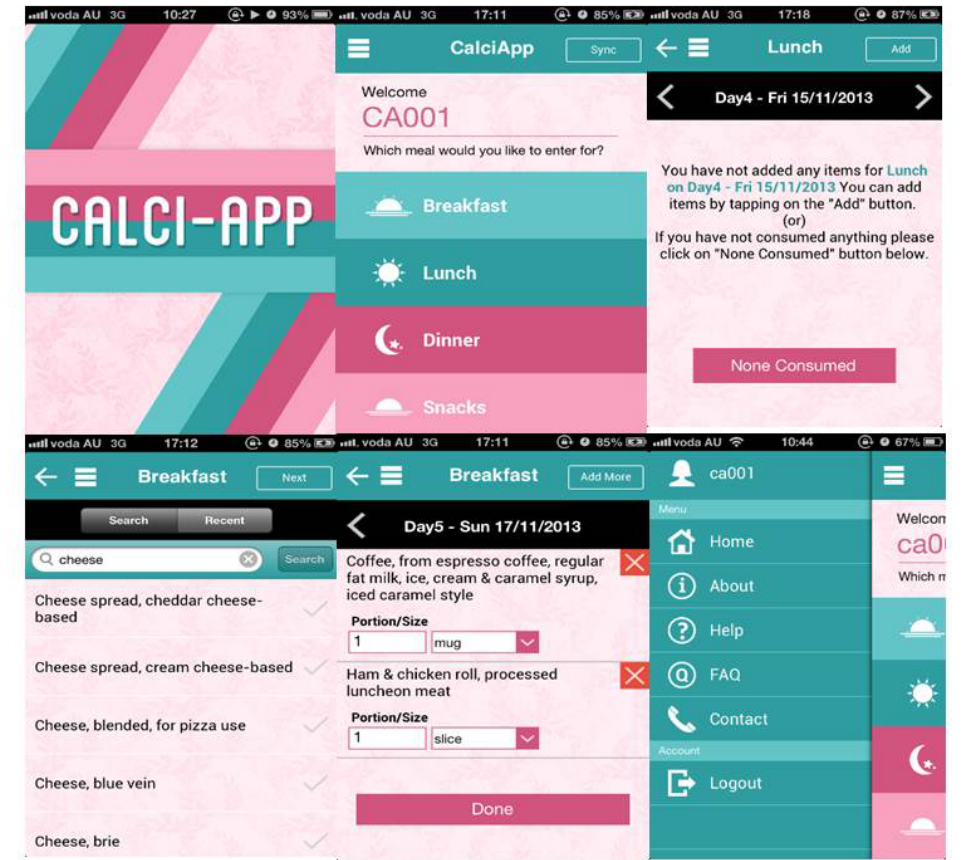
Figure 1. Screenshots of Calci-app